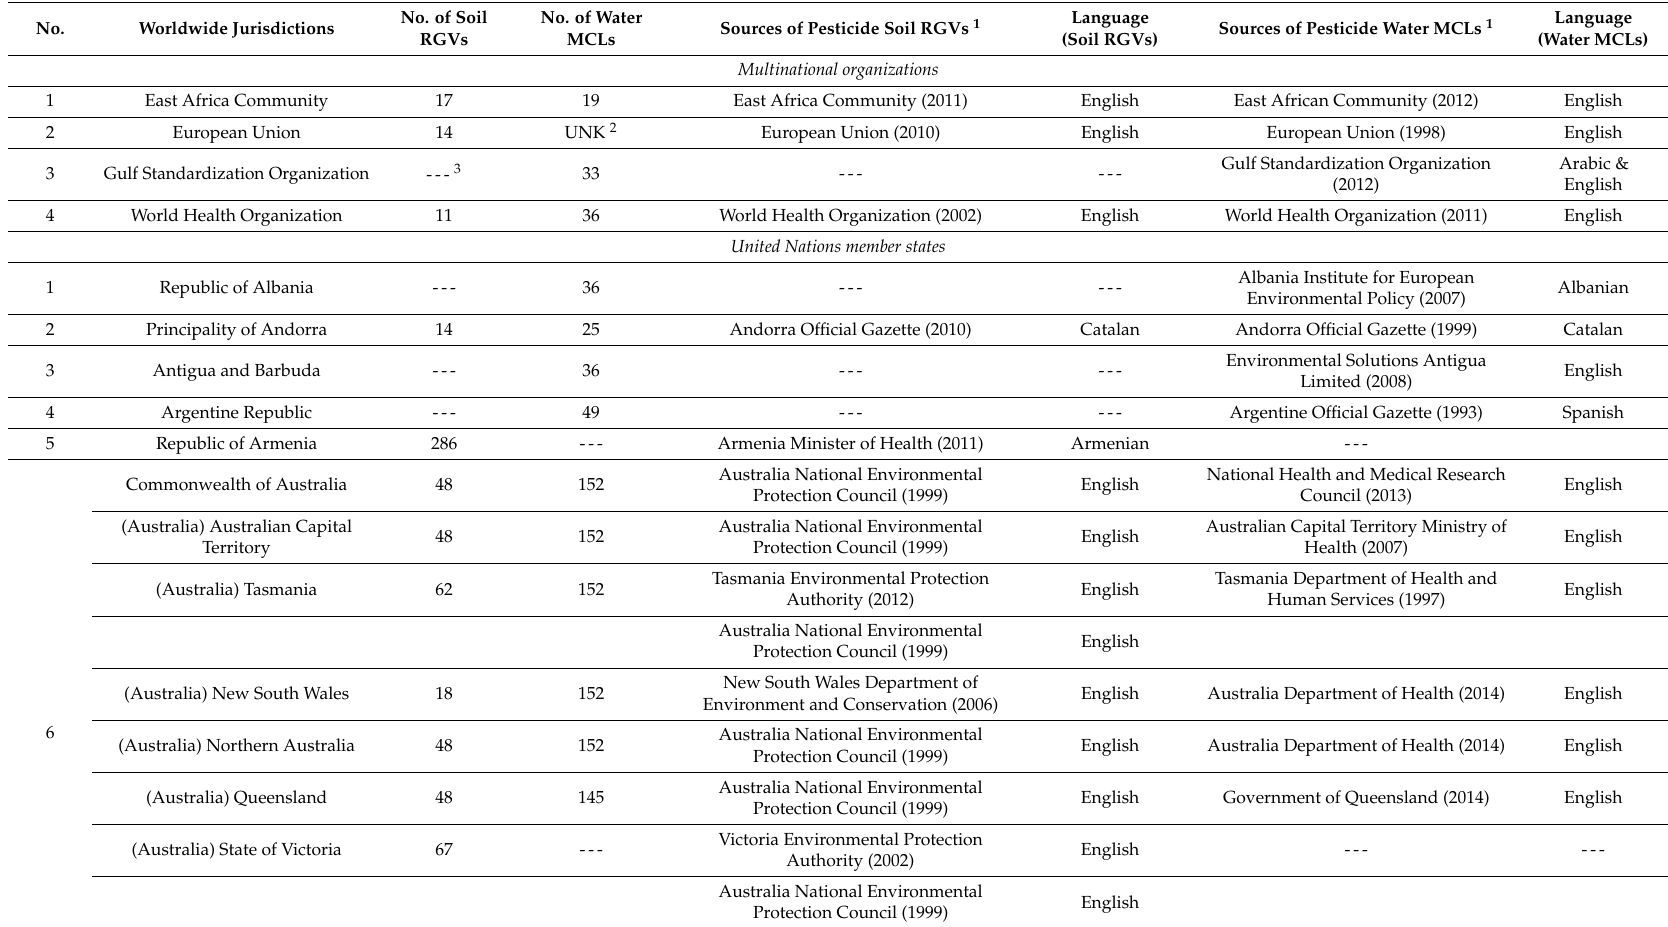
Table 1. Worldwide (outside of U.S.) pesticide regulatory guidance values (RGVs) and maximum concentration levels (MCLs) jurisdiction sources for nations, regions, territories, and multi-national